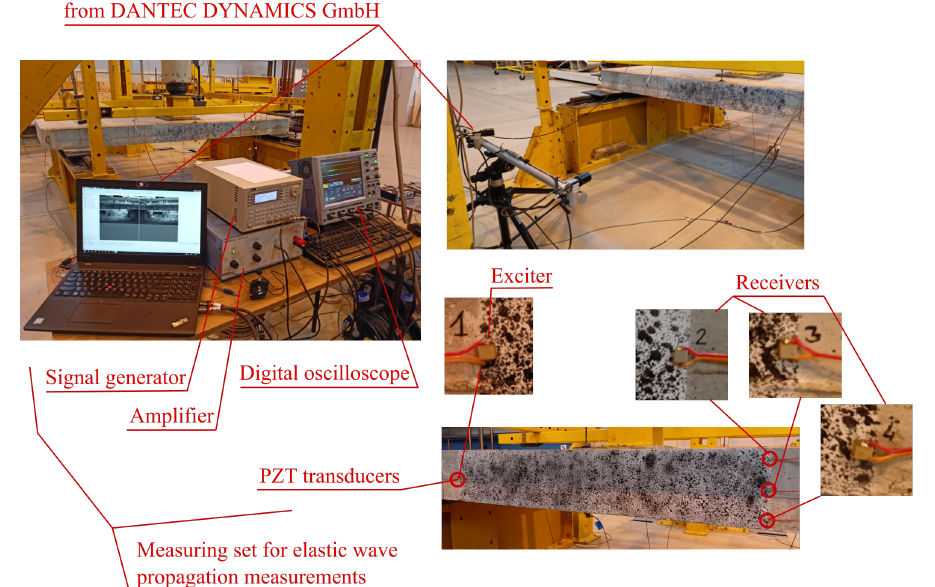
Figure 2. Measuring